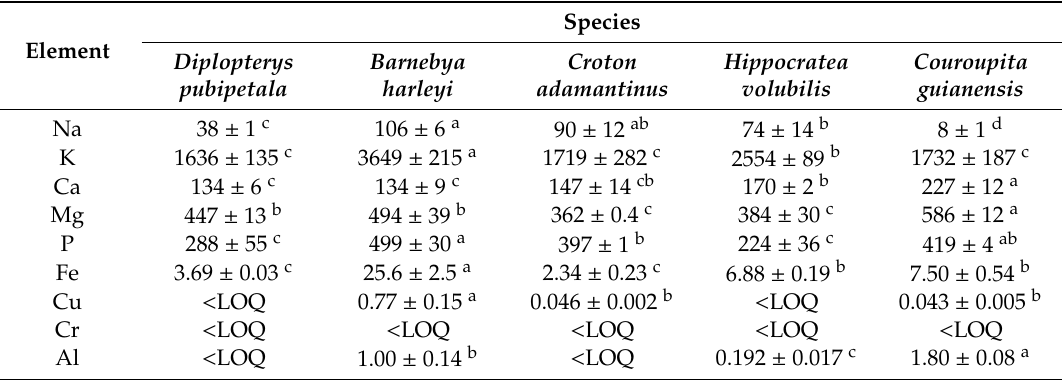
Table 3. Mineral concentrations ( µ g / g dry weight (dw)) of the analyzed